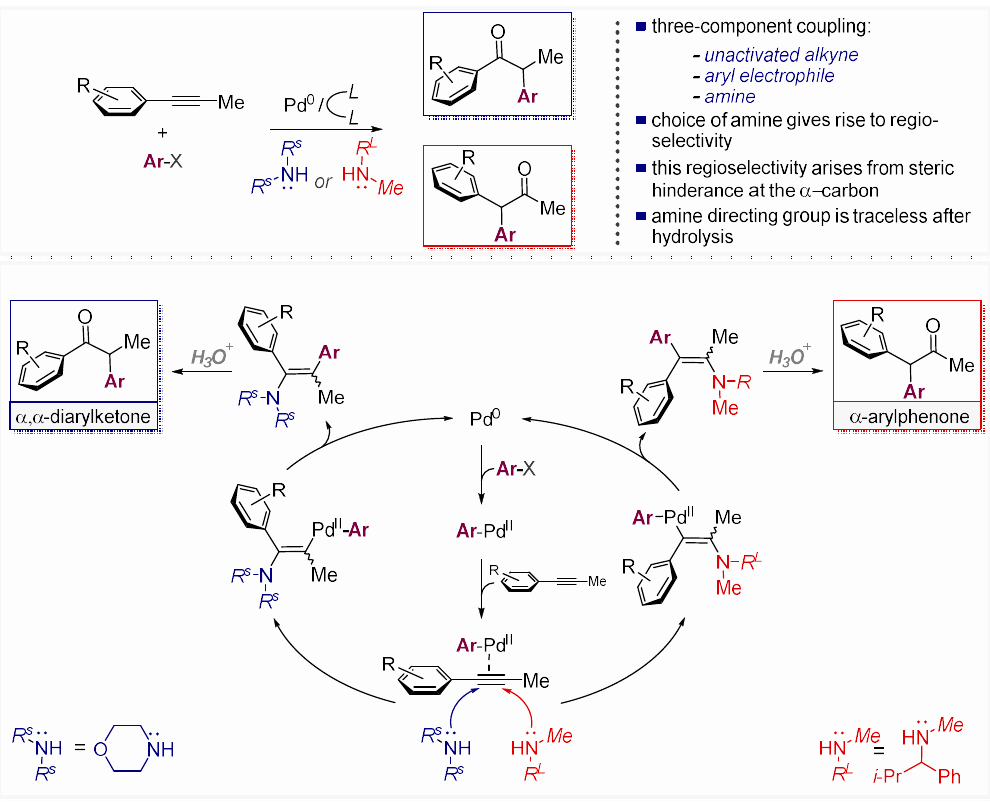
Scheme 5. Synthesis of α-arylphenones and α,α-diarylketones through directed catalytic alkyne